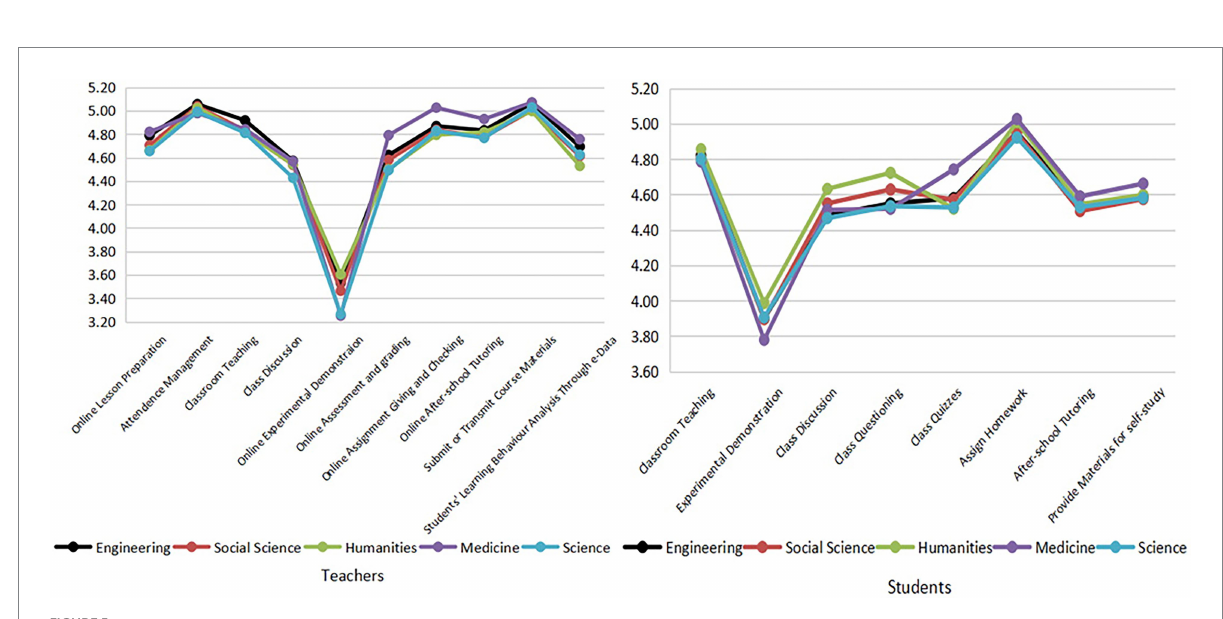
FIGURE 5 The evaluation of online pedagogical approaches by teachers and students of different